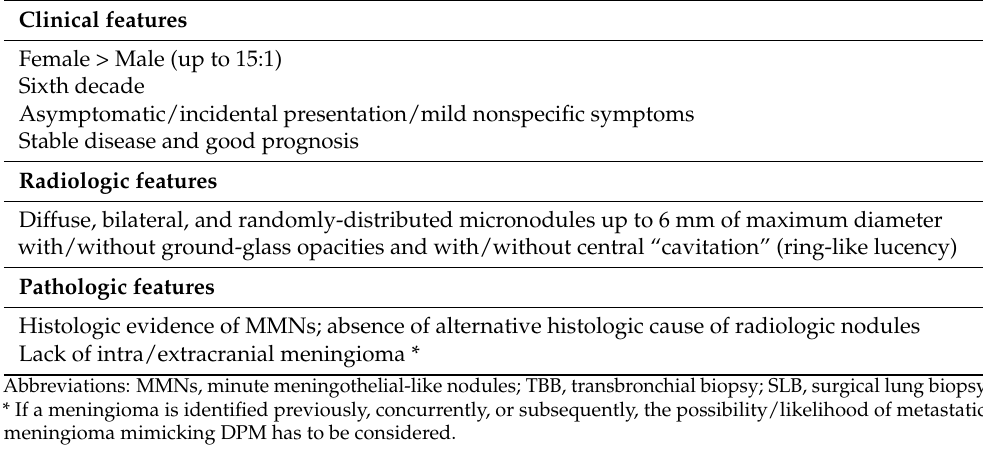
Table 3. Clinicopathologic characteristics of diffuse pulmonary meningotheliomatosis